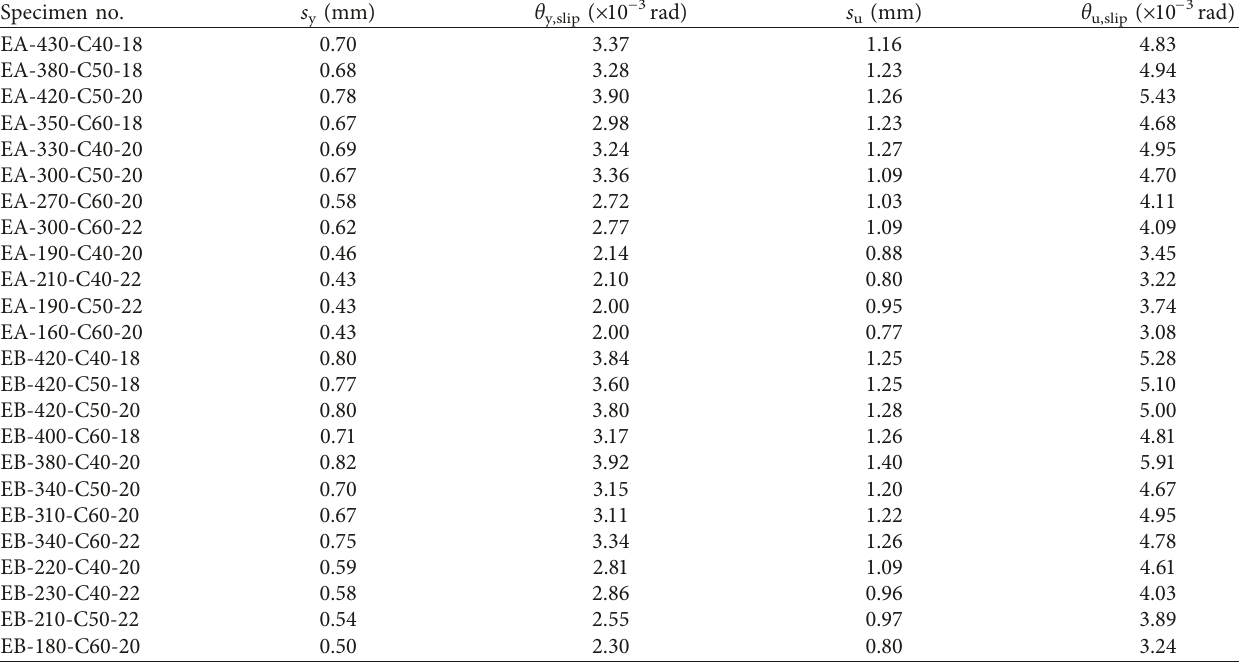
Table 8: Additional fixed-end rotation of exterior beam-column connection at yielding and nominal ultimate states. Specimen no.